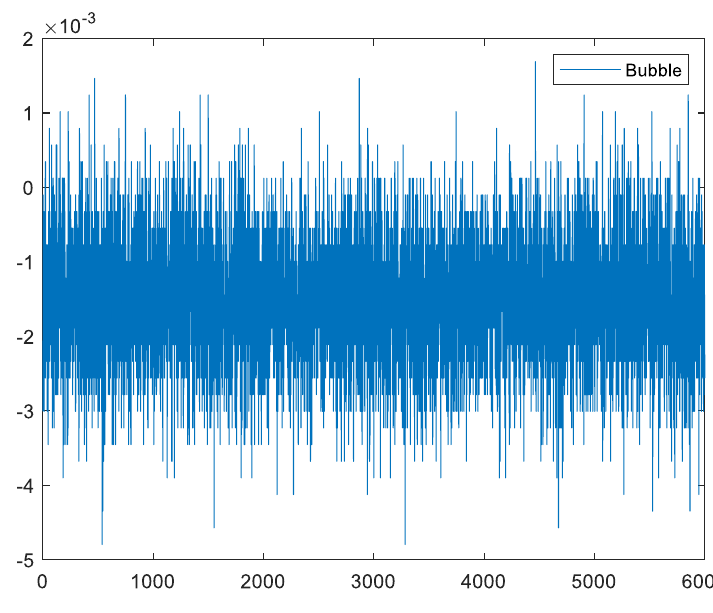
Figure 4. Wavelet output of a faulty signal.